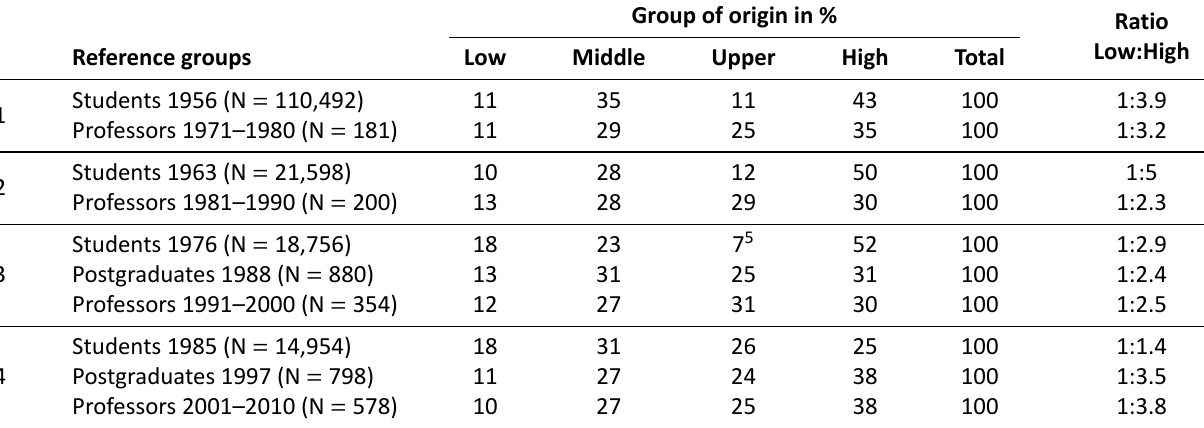
Table 1. Cross-sectional comparison between the social origins of students, doctoral candidates, and professors in % (Stu- dents: N = 165,800, Postgraduates: N = 1,587; Professors N = 1,313). Source: for the student data: 3rd, 5th, 8th, and 11th Sozialerhebung (Deutsches Studentenwerk, 1957, 1964, 1977, 1986). For the doctoral data: unpublished special evalua- tion of the 12th and 15th Sozialerhebung. For the data of the professors: survey at North Rhine-Westphalian universities 2010 (Möller, 2015, p.